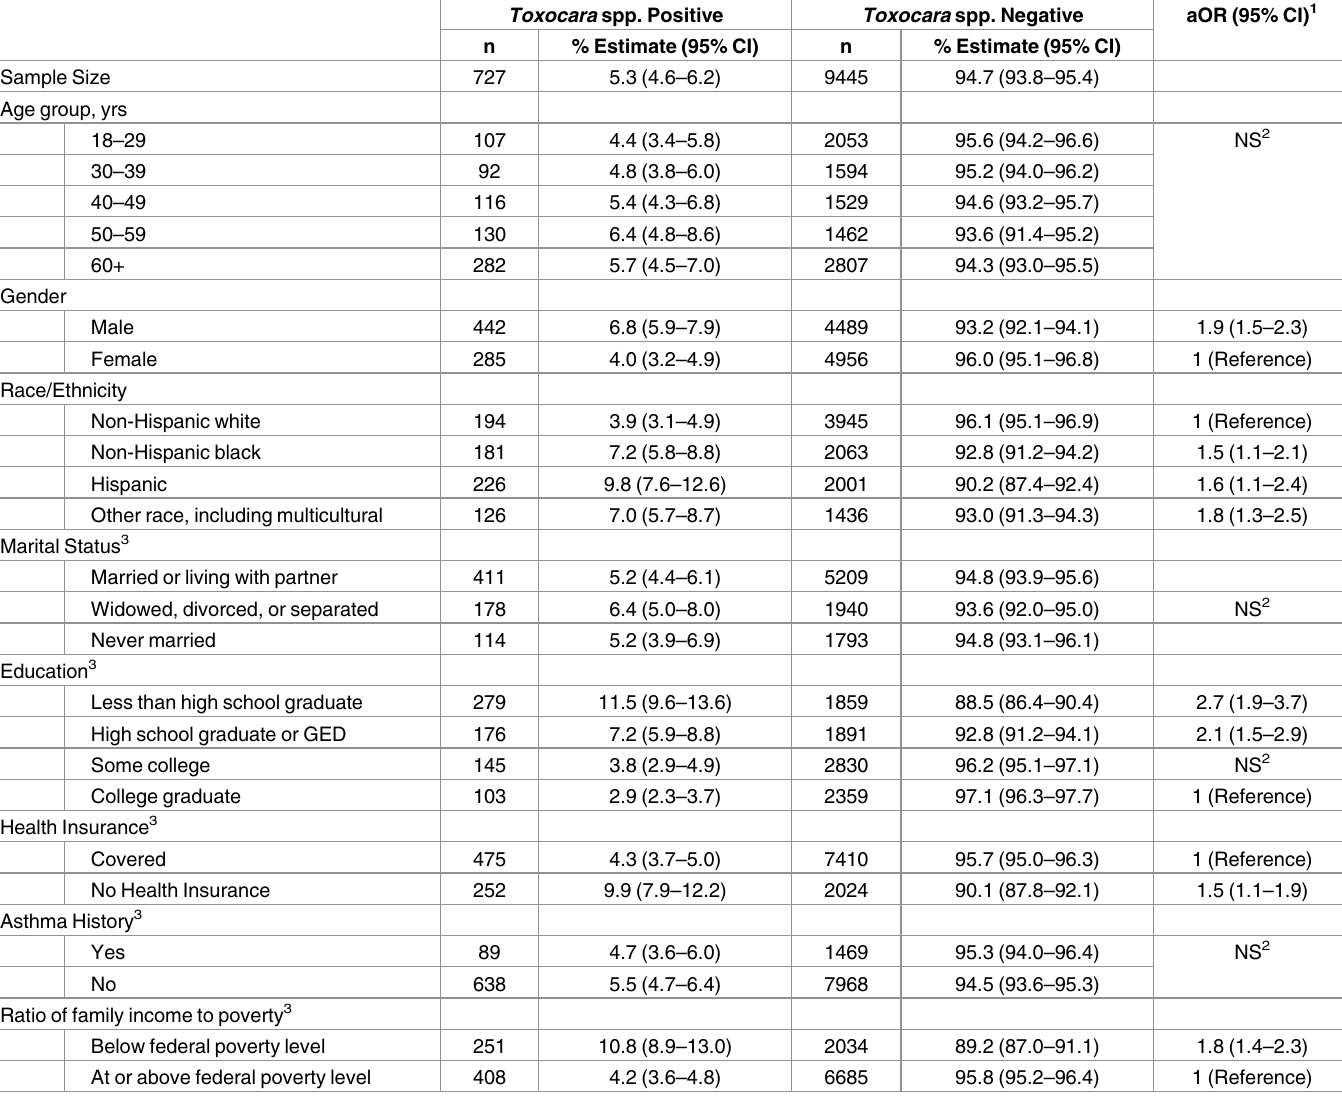
Table 2. Characteristics associatedwith Toxocara spp. infection in adults.